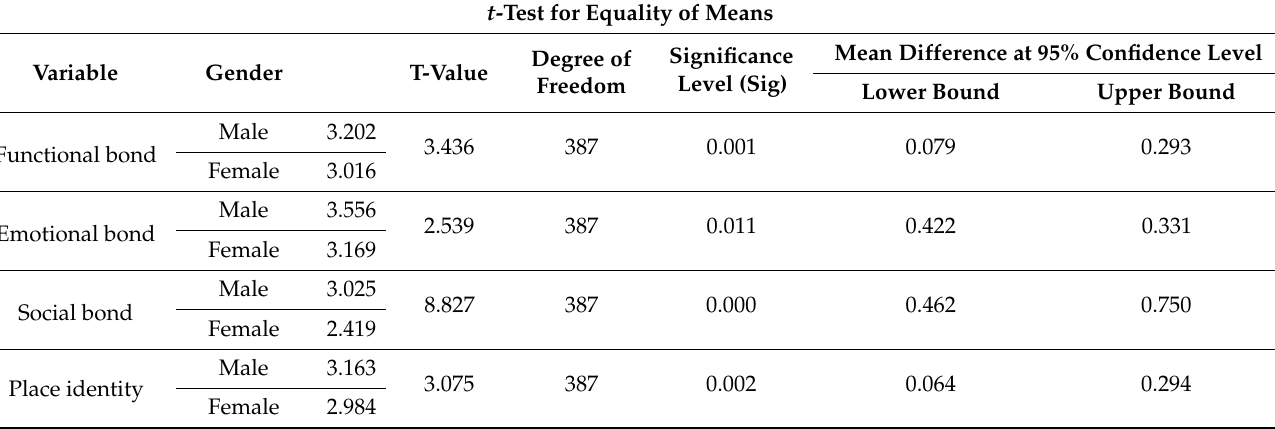
Table 5. Independent two-sample t -test for evaluation of the effect of gender. t -Test for Equality of